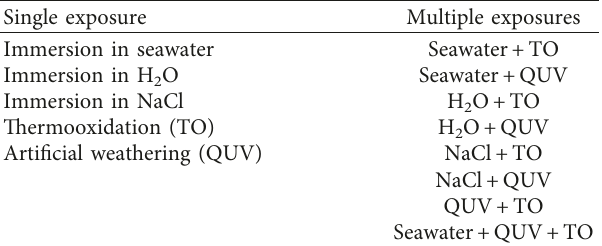
Table 2: Degradation tests